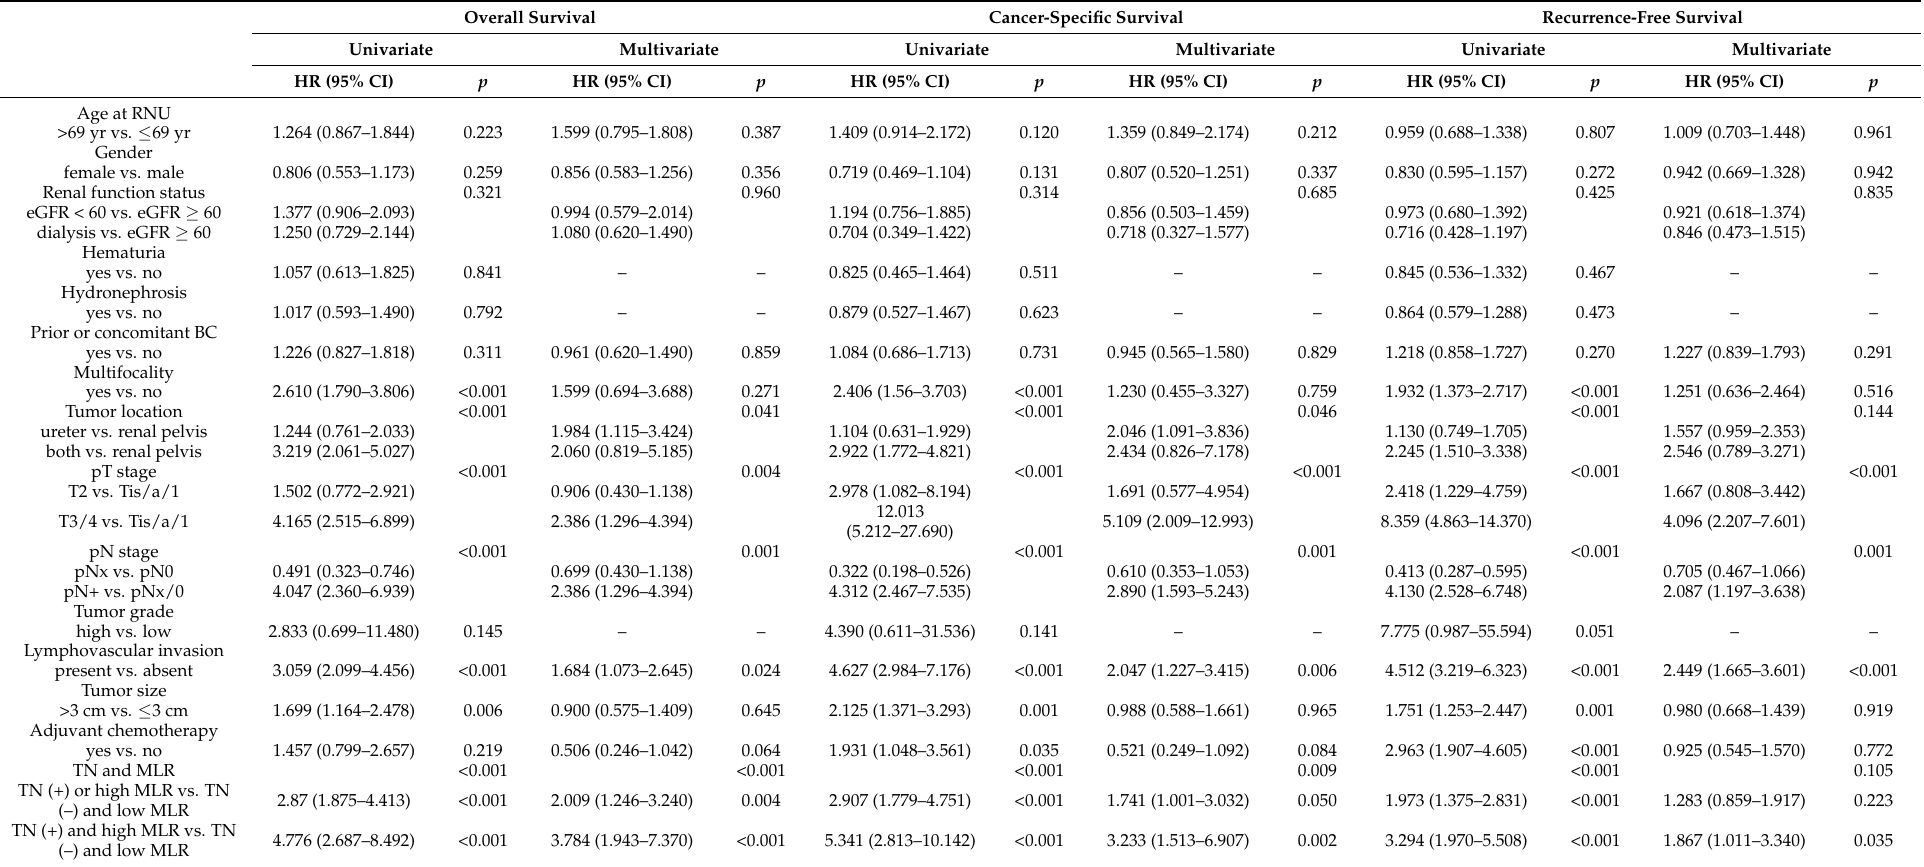
Table 2. Univariate and multivariate Cox regression analyses for predicting overall survival, cancer-specific survival, and recurrence-free survival in patients treated with radical nephroureterectomy for upper tract urothelial carcinoma. Overall Survival Cancer-Specific Survival Recurrence-Free Survival Univariate Multivariate Univariate Multivariate Univariate